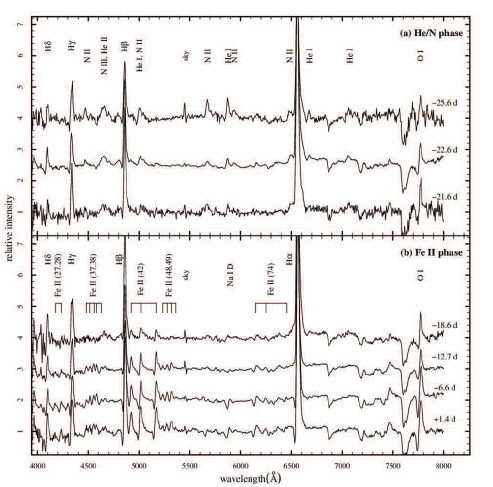
Figure 1: Spectral evolution of T Pyxidis. Upper panel denotes earlier stage,which shows He/N feature. On the contrary lower panel is later stage that shows typical FeII spectral phase. The date after maxi- mum light (minus means before maximum) are denoted on the right shoulder on each spectrum.